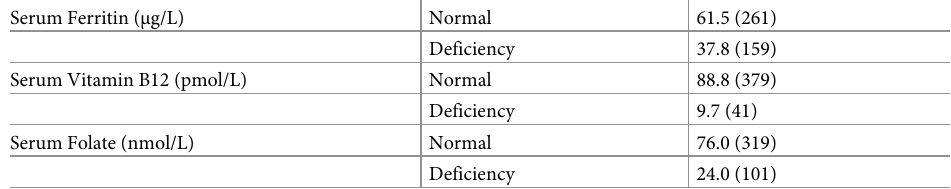
Table 1. The prevalence of serum ferritin, vitamin B12, and folate deficiencies among pregnant women in Mbeya Tanzania (n = 420). Serum Ferritin ( μ